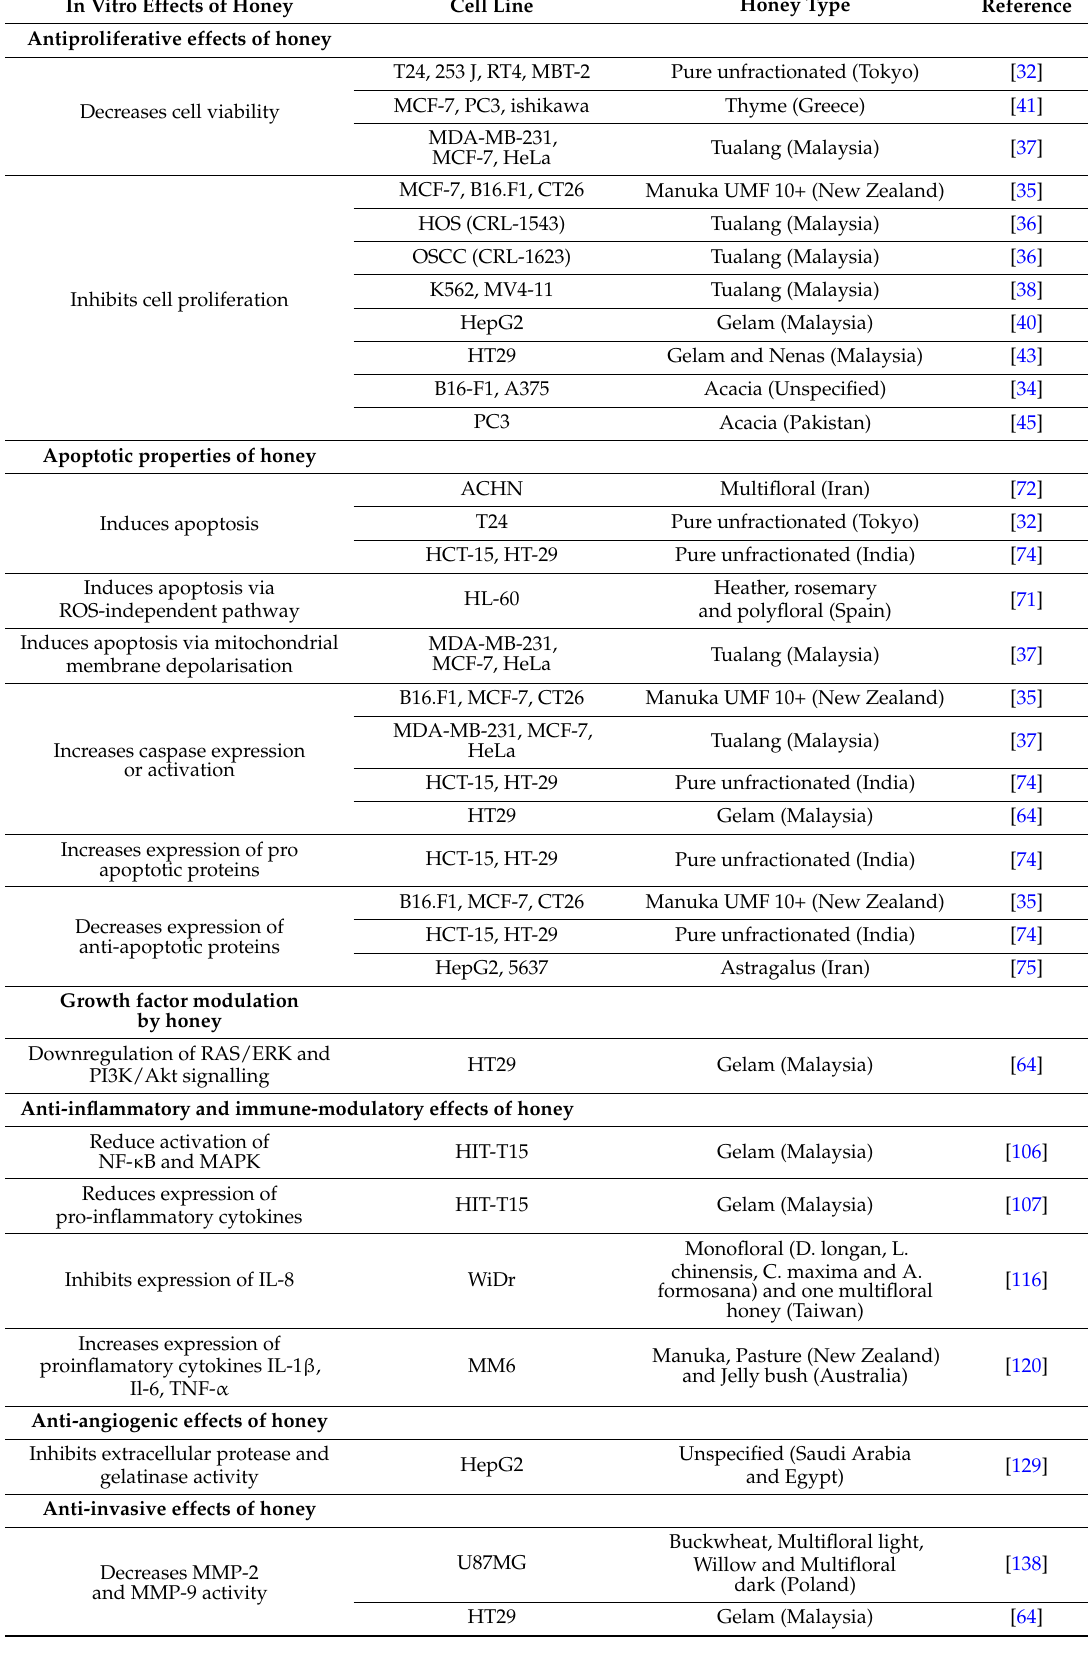
Table 1. The in vitro effects of a variety of honey types on a range of cancer cell lines. In Vitro Effects of Honey Cell Line Honey Type